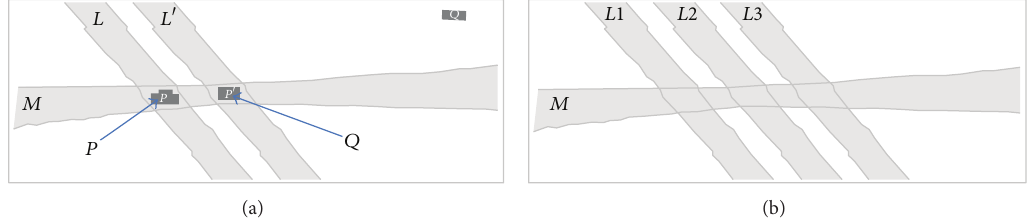
Figure 3: (a) Graduated equality of extended lines compels graduated equality of extended points. (b) Equality of extended lines is not